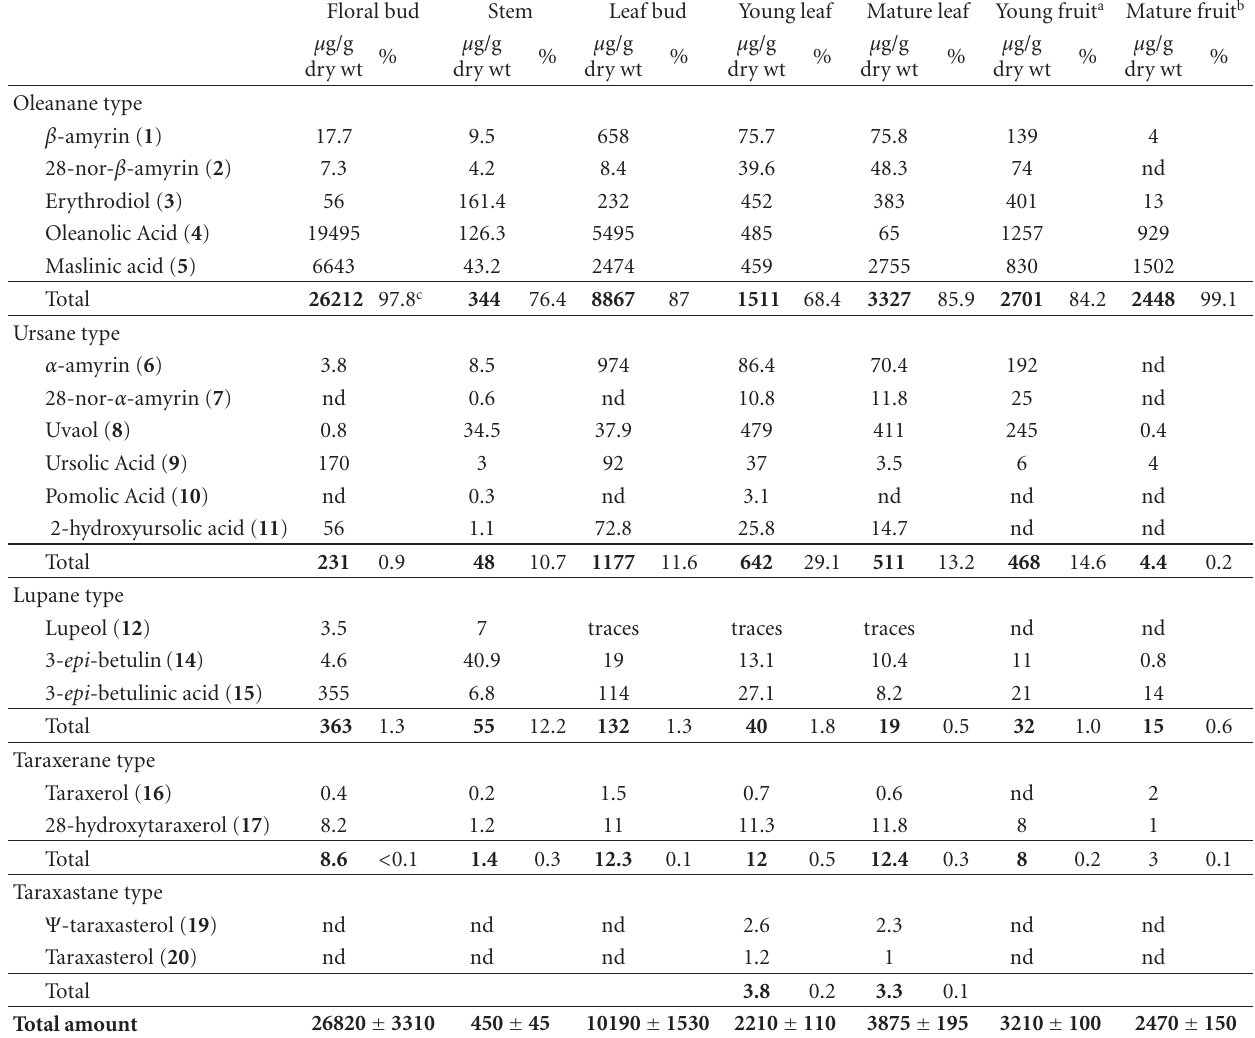
Table 2: Amounts of free nonsterol triterpenoids in various organs of Olea europaea tree. Floral bud Stem Leaf bud Young leaf Mature leaf Young fruit a Mature fruit